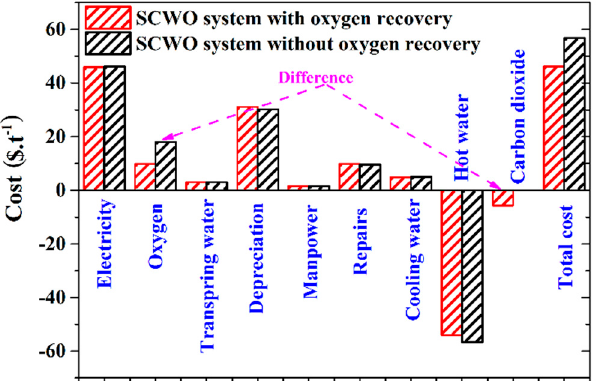
Figure 10. The treatment cost comparisons for SCWO systems with and without OR, the prices for electricity, oxygen, transpiring water and cooling water, are 0.079 $/kW·h, 100 $·t − 1 , 0.8 $·t − 1 , and 0.24 $·t − 1 , respectively; the manpower is 6000 $/man·year; the income for hot water and CO 2 are 2.7 $·t − 1 and 71.4 $·t − 1 ,